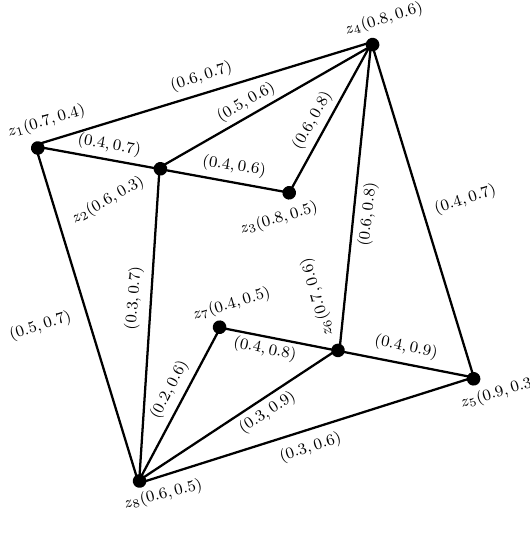
Figure 3. Pythagorean fuzzy